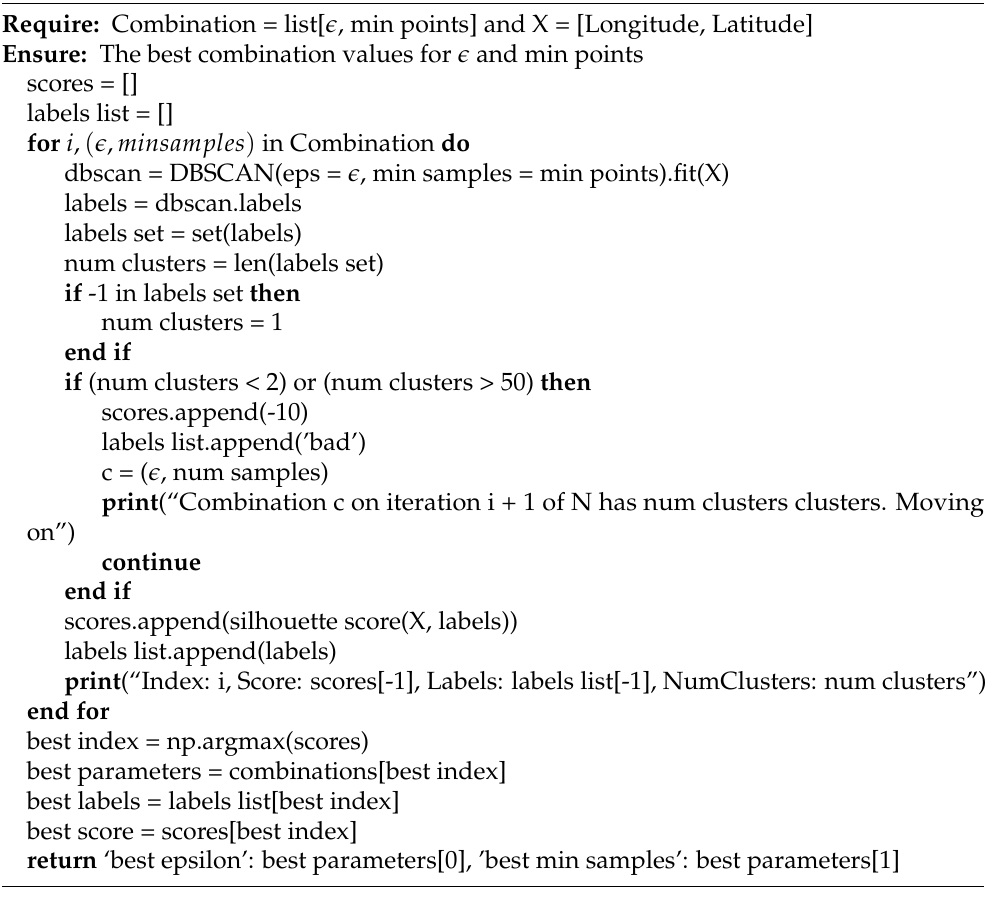
Algorithm 1 Proposed algorithm for finding the best combination of DBSCAN